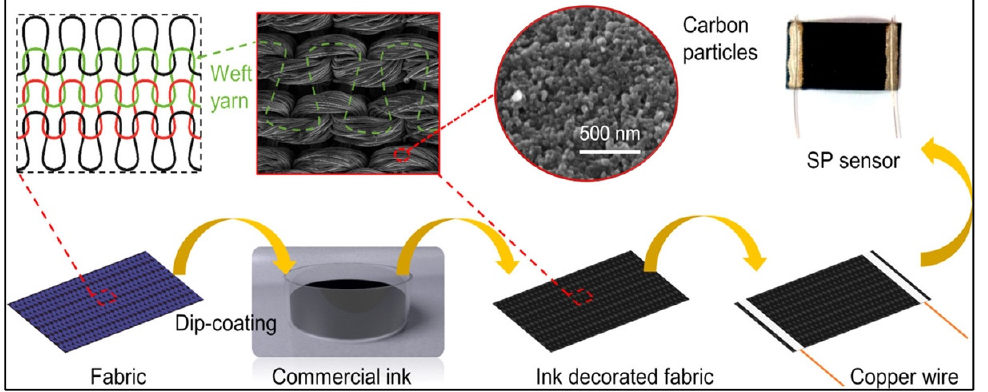
Figure 5. Schematic illustration of the fabrication process of an ink-decorated fabric strain sensor. First, the fabric is washed three times with deionized water, followed by dip coating in commercial ink, which is absorbed and dried in an oven at 60 °C for 1 h. Next, two copper wires are mounted onto the two ends of the fabric strip using silver paste to improve integration, which is dried again and ready for use with textiles. Reprinted with permission from [66]. Copyrights (2020), American Chemical Society.